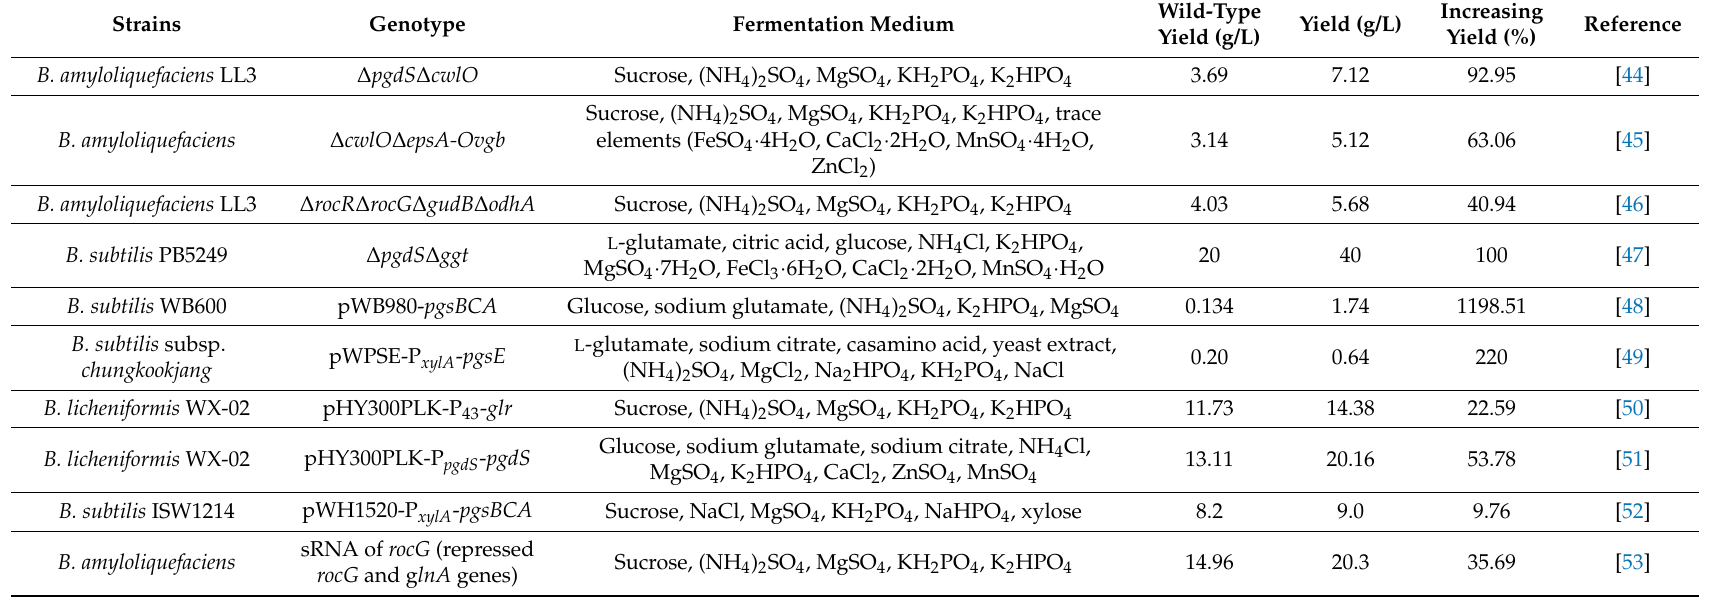
Table 2. Recombinant Bacillus strains generated for increased γ -PGA